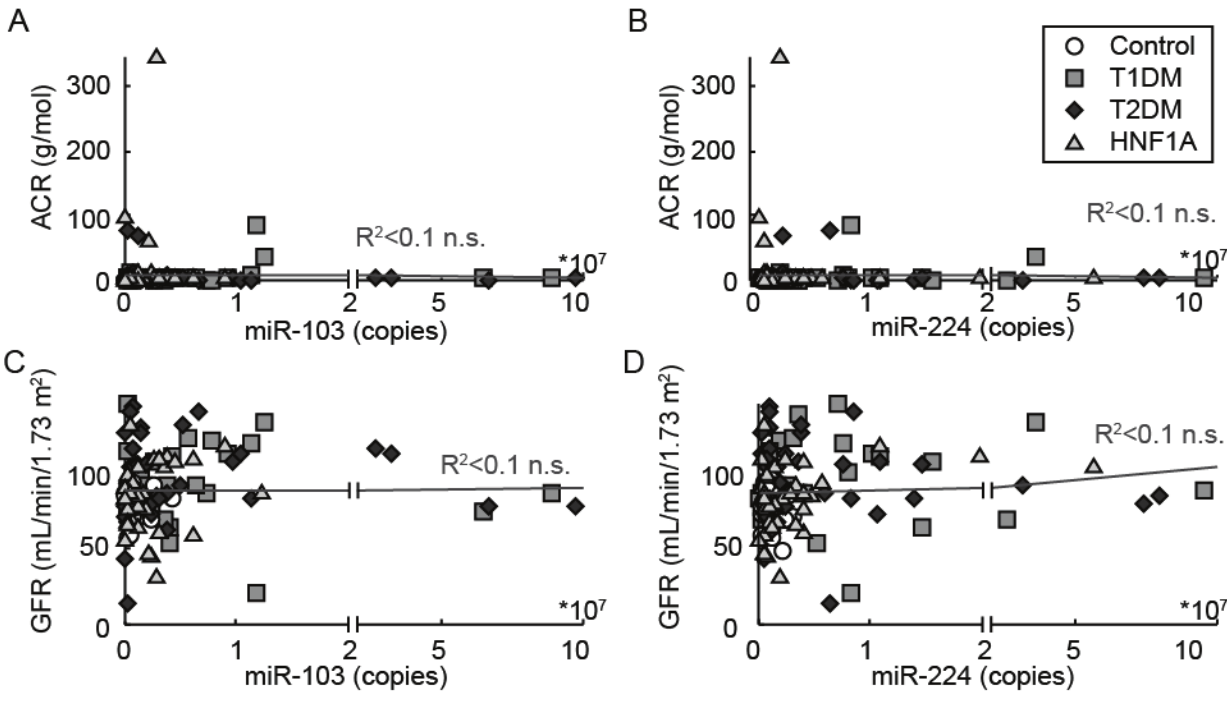
Figure 4. Correlation of miR-224 and miR-103 with renal indices; eGFR/ACR. Linear regression analysis indicates no statistically significant association of miR-224/-103 with GFR/ACR in the HNF1A-MODY mutation carrier, T1DM, T2DM and normal control groups; n.s. not